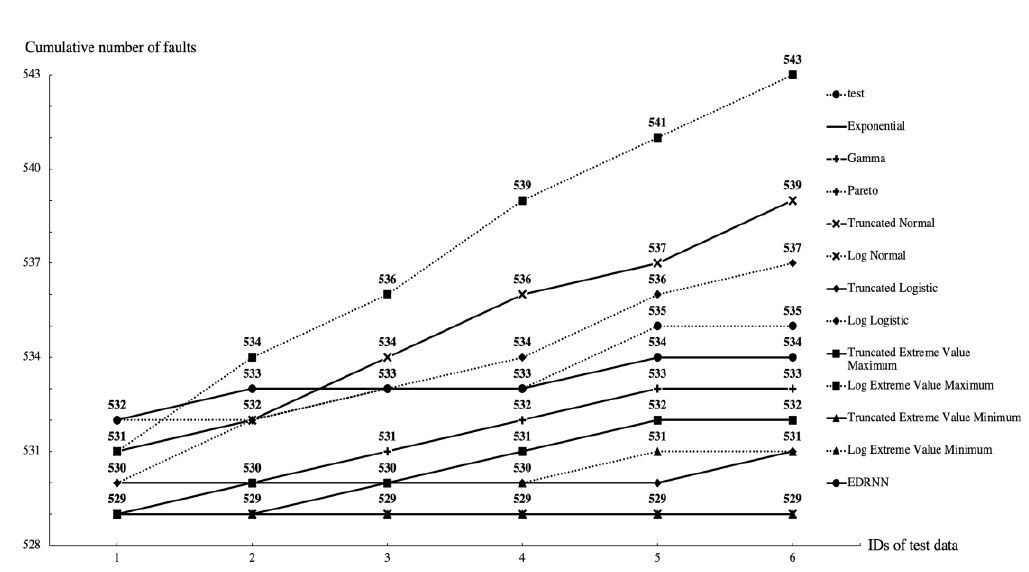
Figure 6. Predicted results of the proposed model (EDRNN) compared with 11 SRGMs.